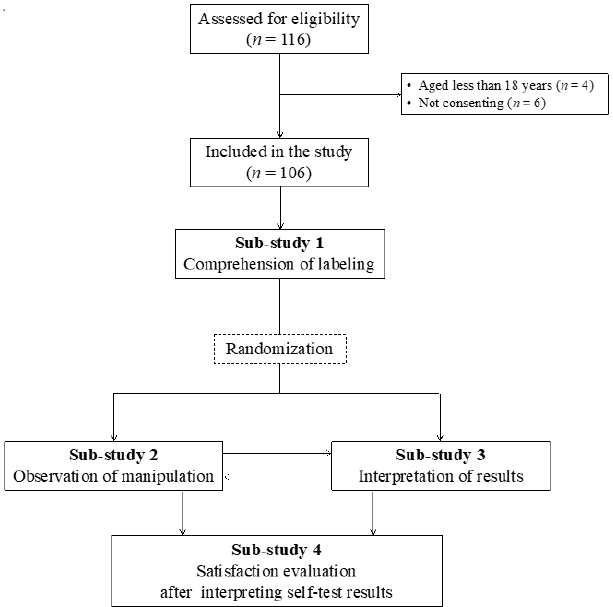
Figure 1. Recruitment of study participants.